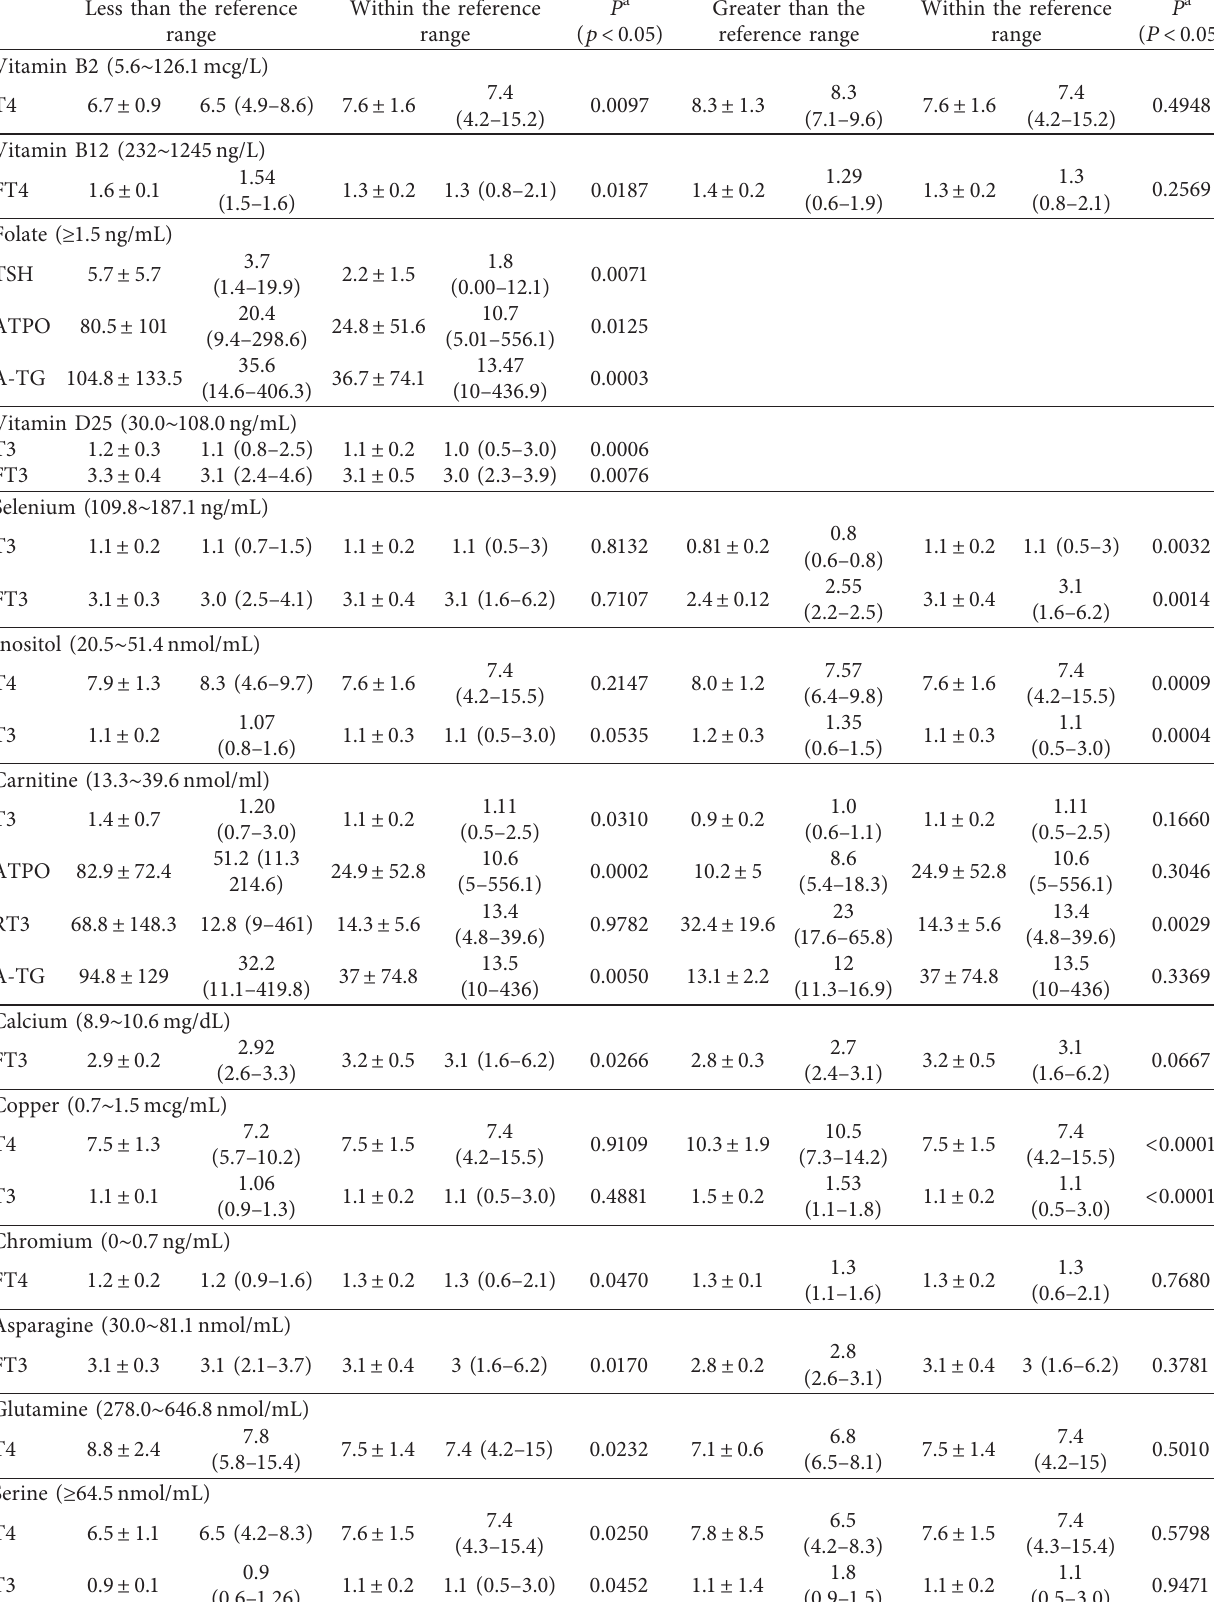
Table 2: Micronutrients with significant association with thyroid